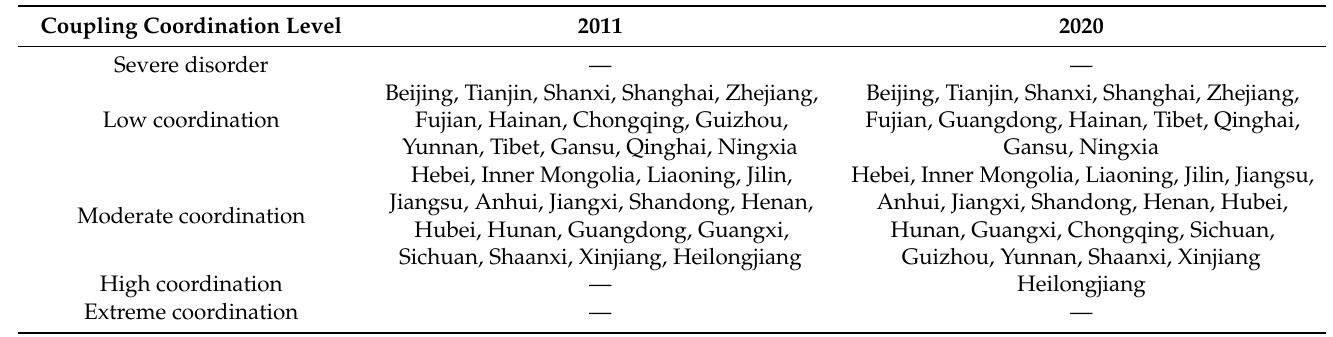
Table 8. Spatial distribution of the coupled and coordinated development of agricultural eco-efficiency and food security in 31 provinces from 2011 to